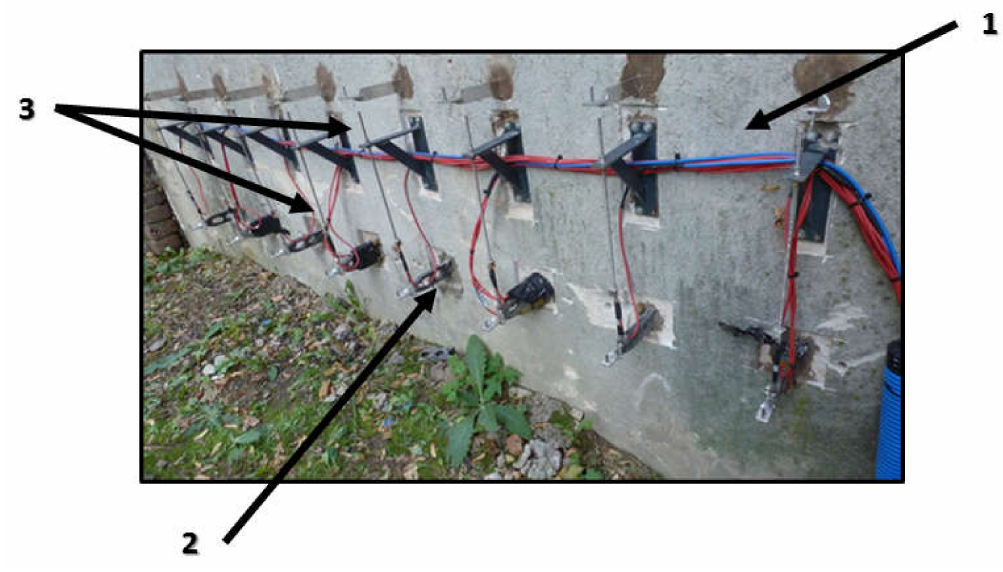
Figure 20. Experimental site for anchorage tests with measuring equipment prepared for hanging elevation panels: (1) load-bearing wall, (2) composite anchor, (3) measuring